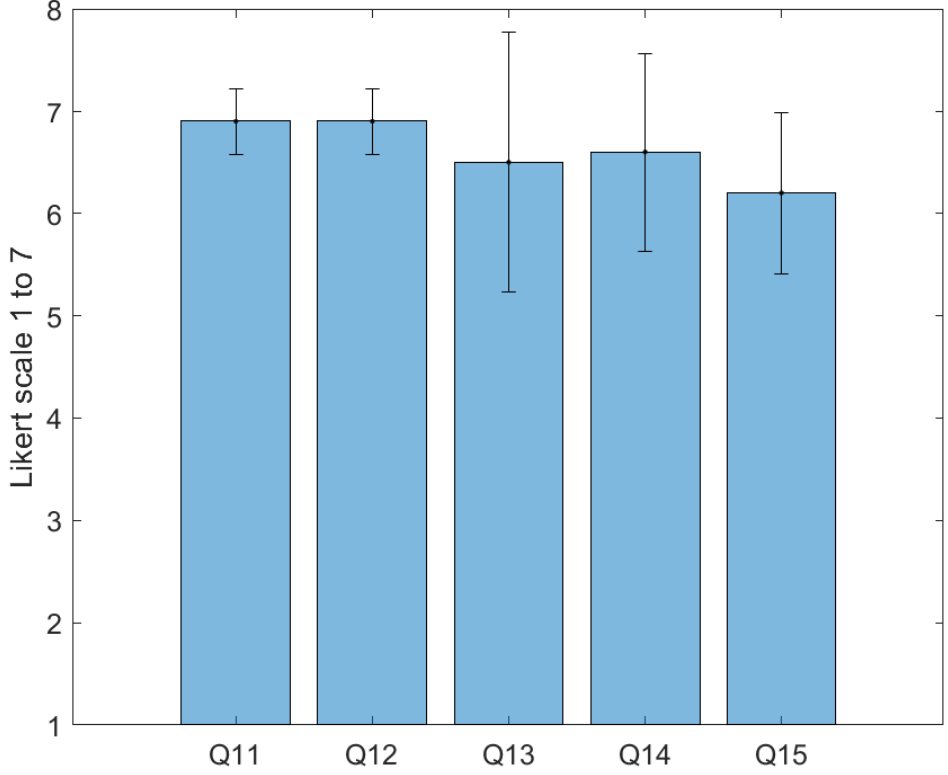
Figure 14. Selected questions from the Igroup Presence Questionnaire results: 1 = “not at all”, 7 =